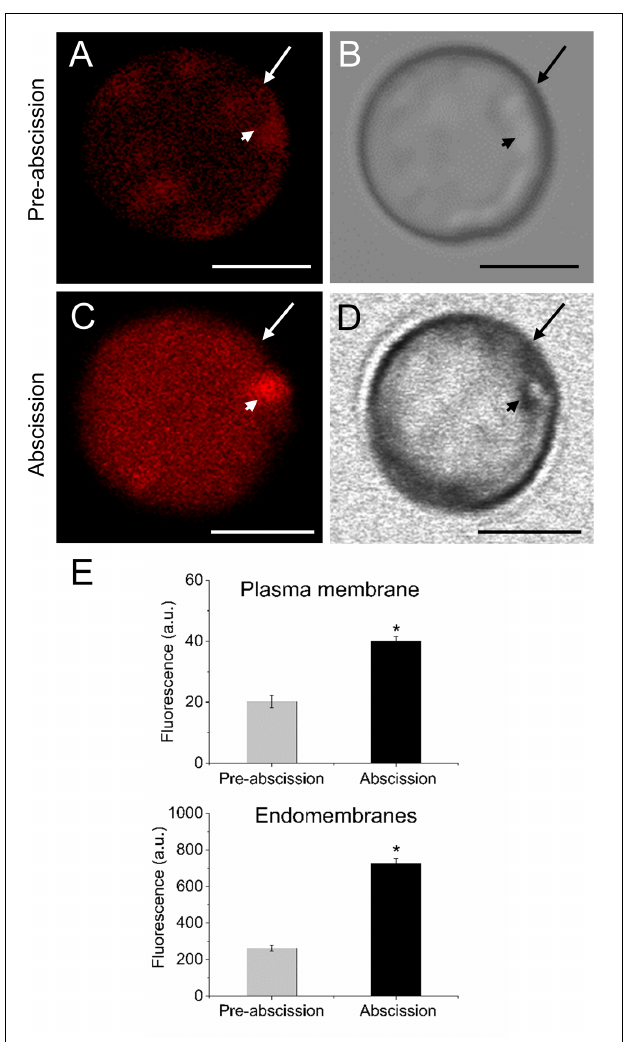
FIGURE 5 | Mature-fruit abscission caused stimulated vesicle trafficking in olive AZ. (A,C) Vesicle trafficking was enhanced in fruit AZ at the abscission stage compared with AZ at the pre-abscission stage. (B,D) White-light image from fruit AZ protoplast at both stages. Fruit AZ protoplasts stained with FM4-64 were observed under a confocal microscope. (E) Relative FM4-64 internalization fluorescence intensity in the plasma membrane (arrow) and the intracellular membranes (arrowhead) in AZ protoplasts at two different stages. About 10 protoplasts were acquired per sample, and data were obtained with FV10 4.2 software (Olympus). Values are means ± SD ( n = 10 protoplasts). Scale bars are 5 µ m. Arrow: plasma membrane. Arrowhead: endomembranes. Statistically significant differences based on unpaired Student’s t -test at P < 0.05 are denoted by an asterisk.